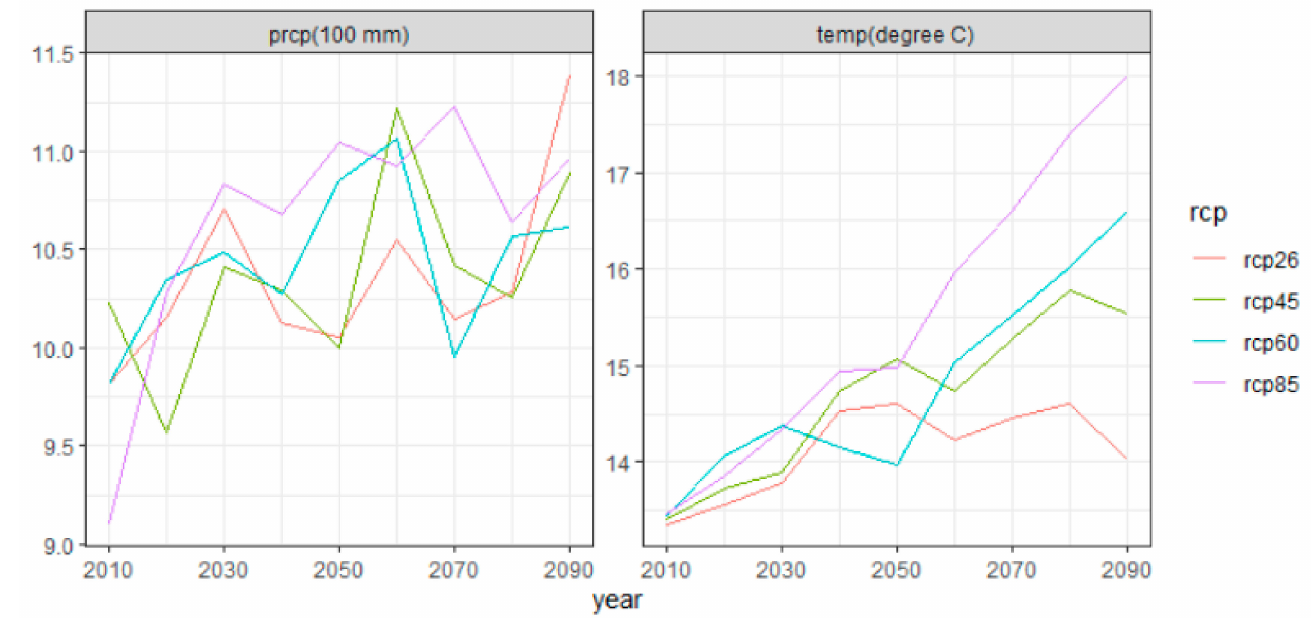
Figure 4. Projected temperature and precipitation by 2090 under climate